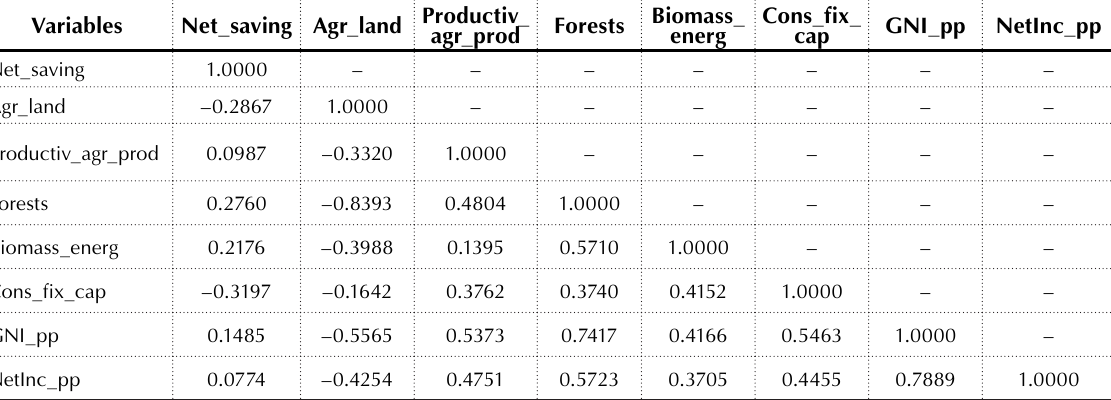
Table 4. Correlation